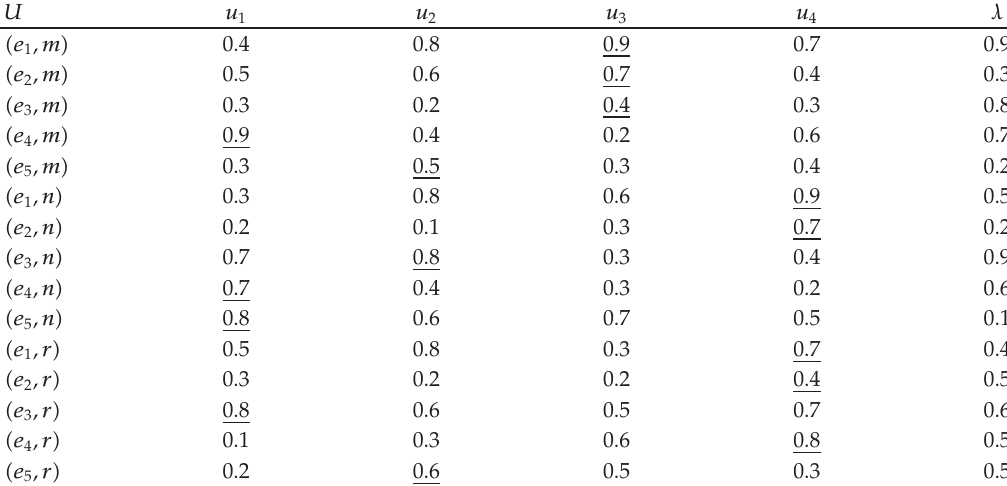
Table 2: Disagree-generalized fuzzy soft expert